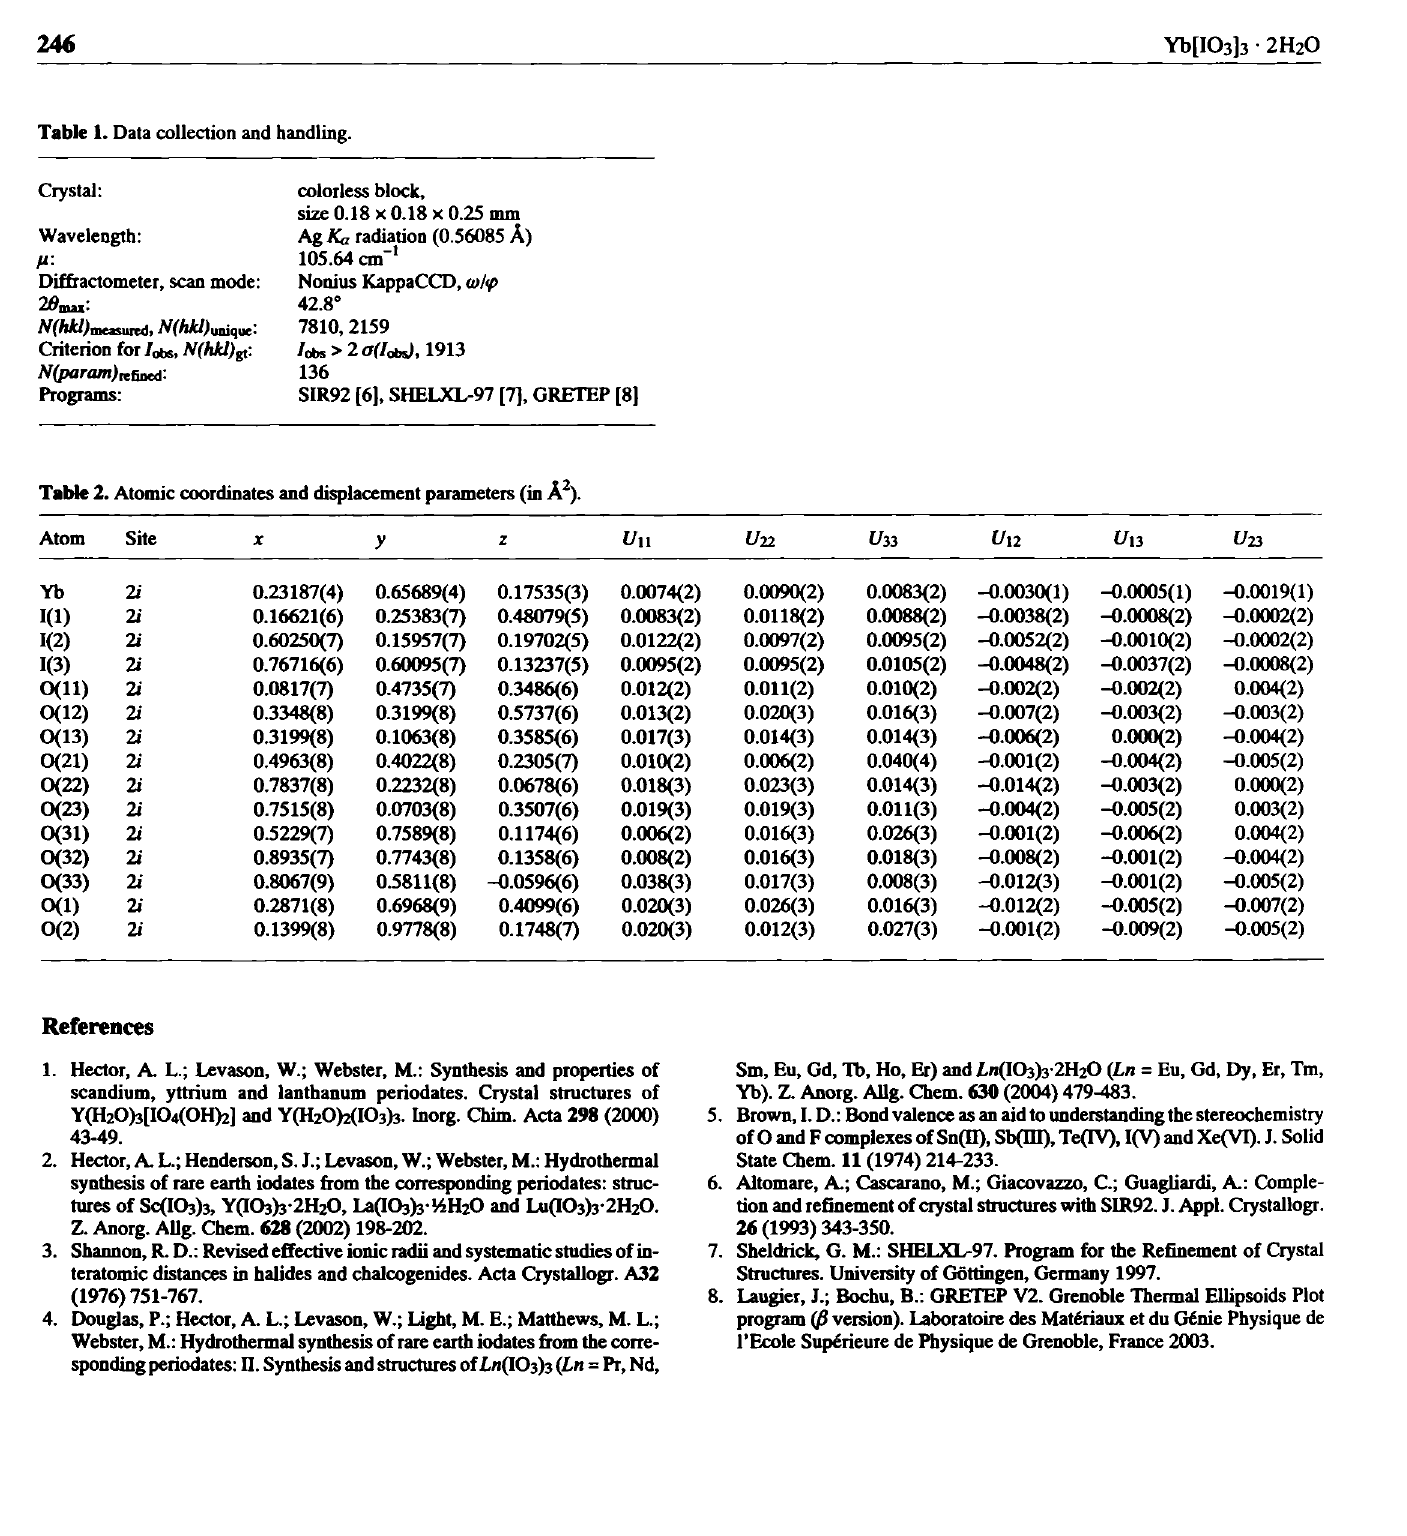
Table 2. Atomic coordinates and displacement parameters (in A 2